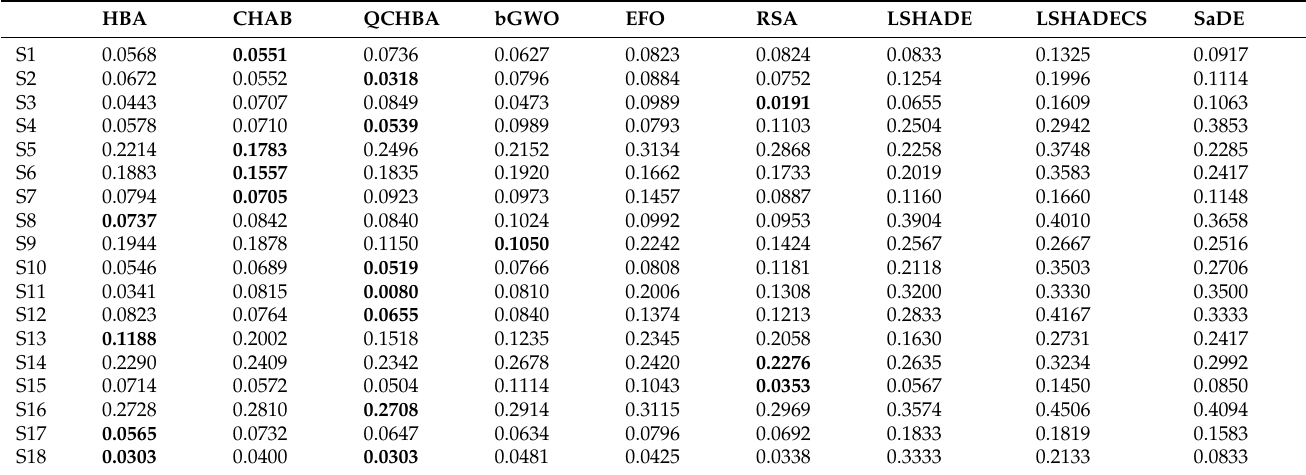
Table 2. Results of QCHBA based on average of fitness